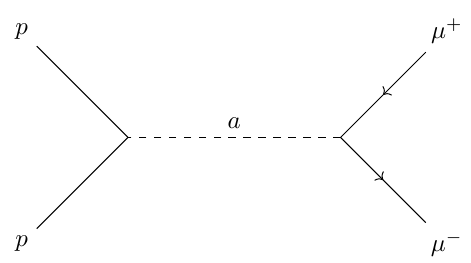
Figure 1 : Feynman diagram of the pp initialised ALPs signal process introduced in section